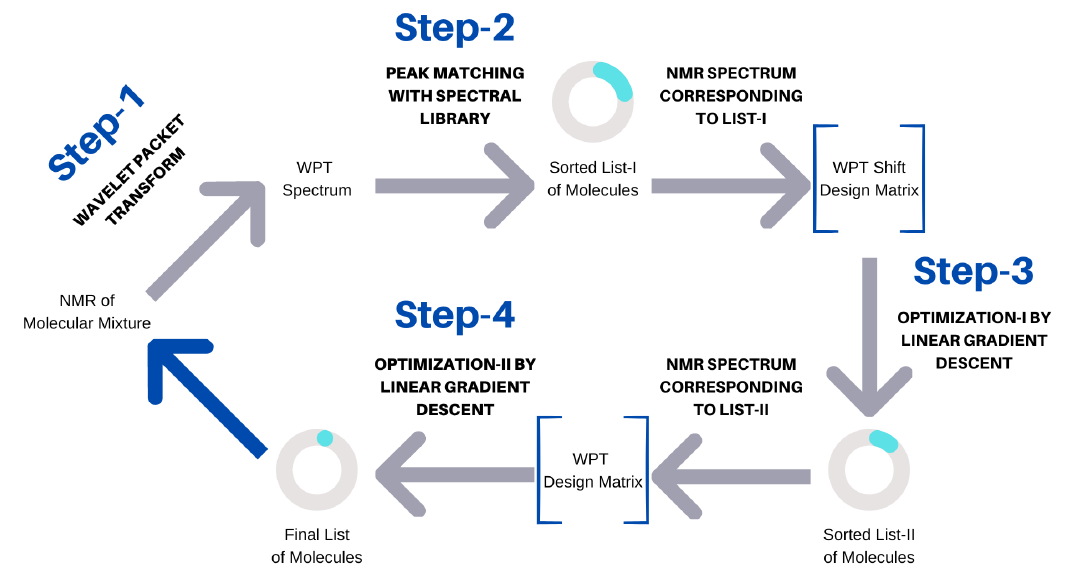
Figure 2. Schematic representation of the spectral analysis algorithm.